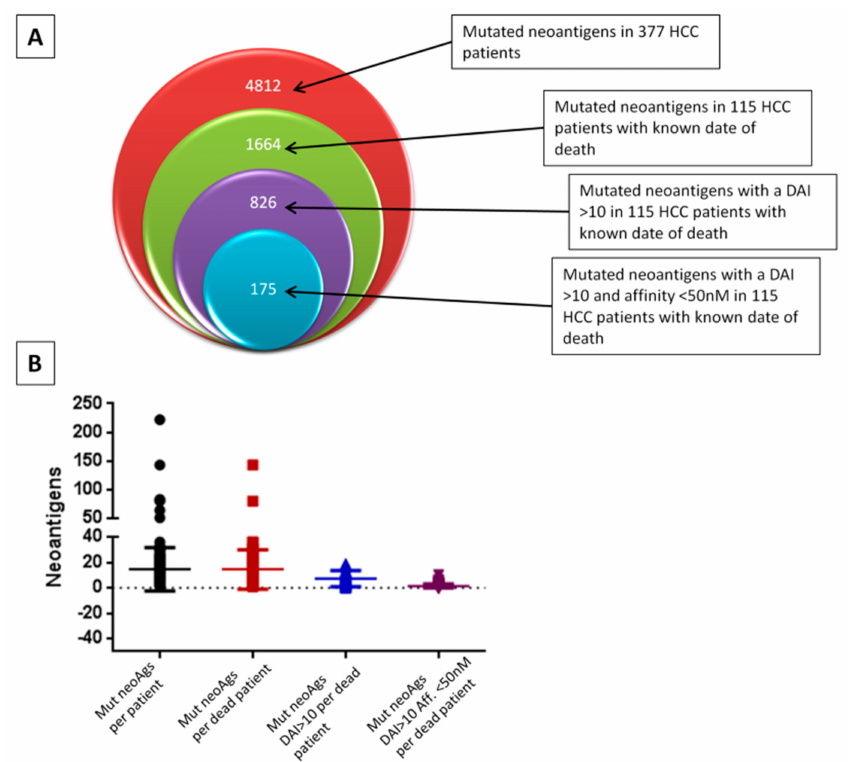
Figure 2. Prediction in HCC samples. ( A ) Neoantigens were predicted by NetMHCstabpan algorithm from the nsSNVs identified in the HCC samples at The Cancer Genome Atlas (TCGA) database. ( B ) Graphic representation of the number of neoantigens predicted in each HCC patient. DAI: di ff erential agretopicity index. nsSNVs: non-synonymous single nucleotide